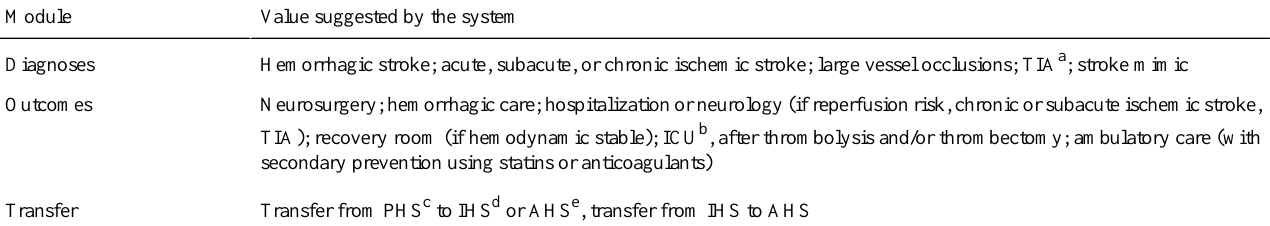
Table 4. Output information in the telestroke system. Value suggested by the